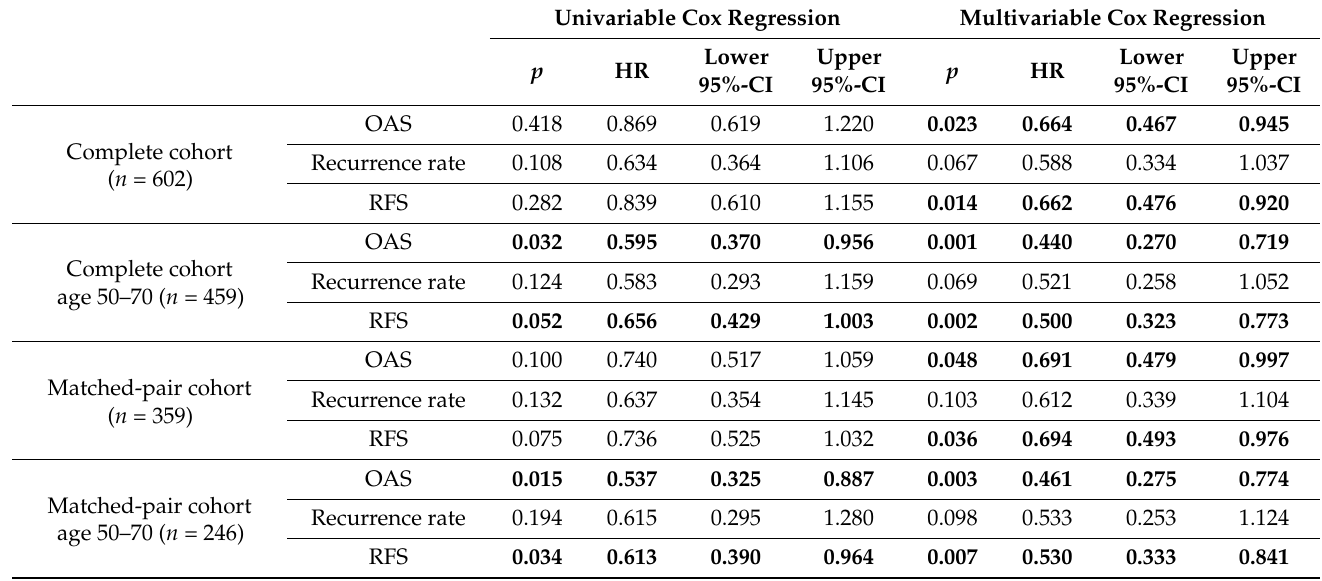
for patients aged under 70 years is added. Multivariable analyses adjusted for age, CCI, UICC stage, grading, lymphatic and vascular invasion. Matching variables are highlighted in